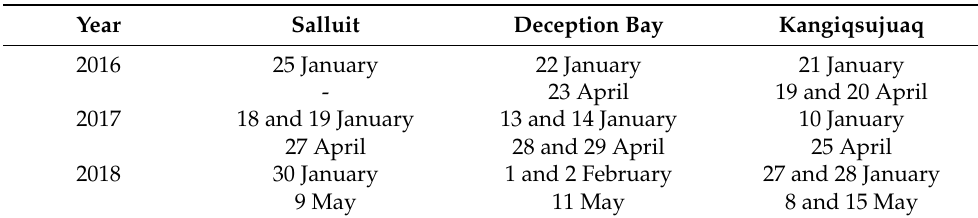
Figure 1. Map of Nunavik in Inuit Nunangat. Inset: Salluit, Deception Bay and Kangiqsujuaq. Table 1. Fieldwork measurement campaign dates.